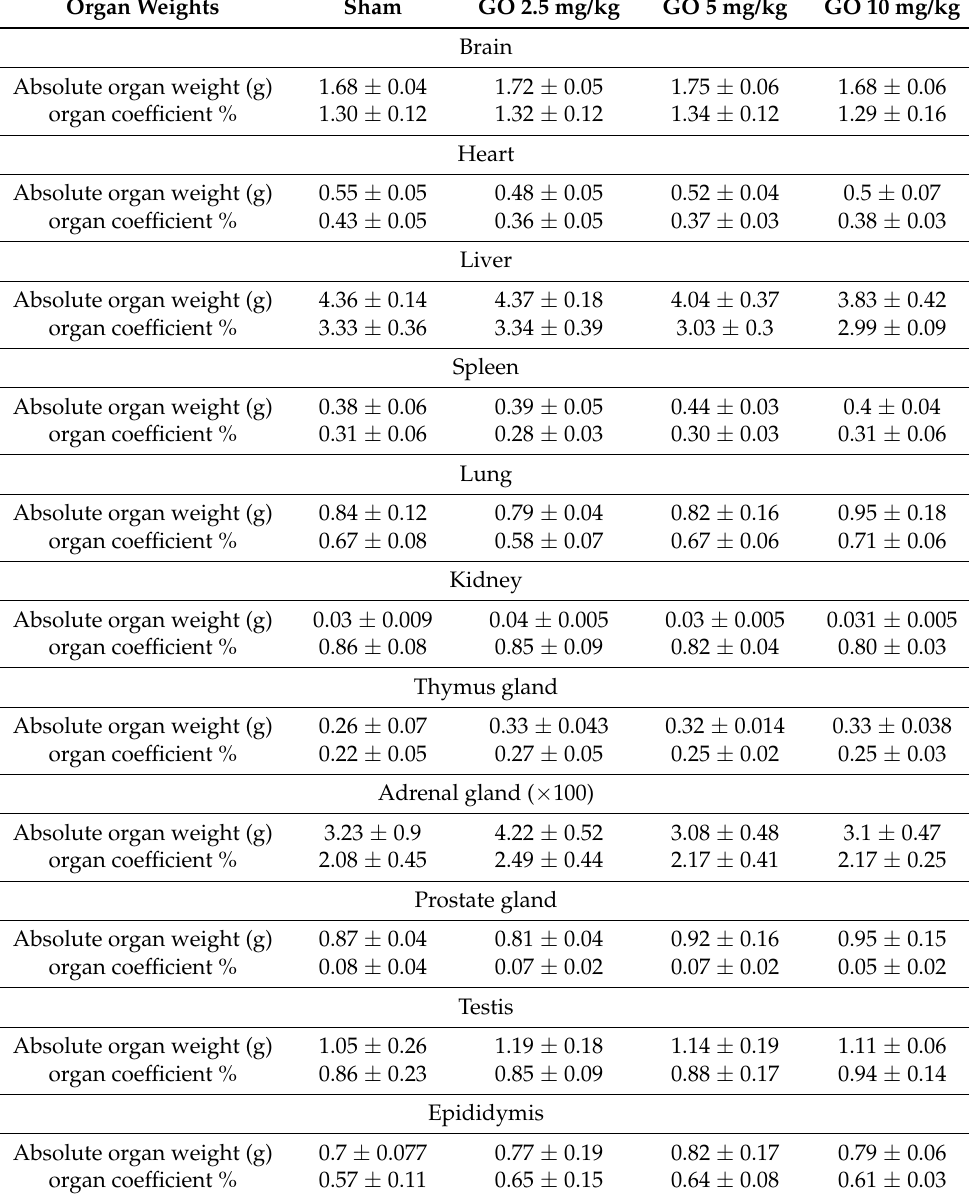
Table 4. Organ weights of rats following injection of GO in the seven-day subchronic toxicity